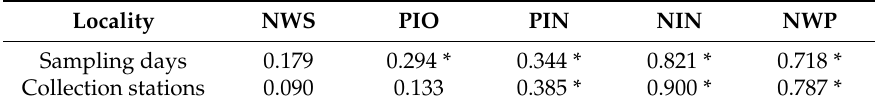
Table 3. Regression statistics for species richness against collection stations and sampling days. Numbers represent R 2 values and asterisks represent significant regression relationships. Data for regression analyses was derived from combined Atlas of Living Australia and Western Australian Museum databases. NWS–North West Shelf, PIO–Pilbara Offshore, PIN–Pilbara Nearshore, NIN– Ningaloo and NWP–North West Province. * Refers to significant test p < 0.05.